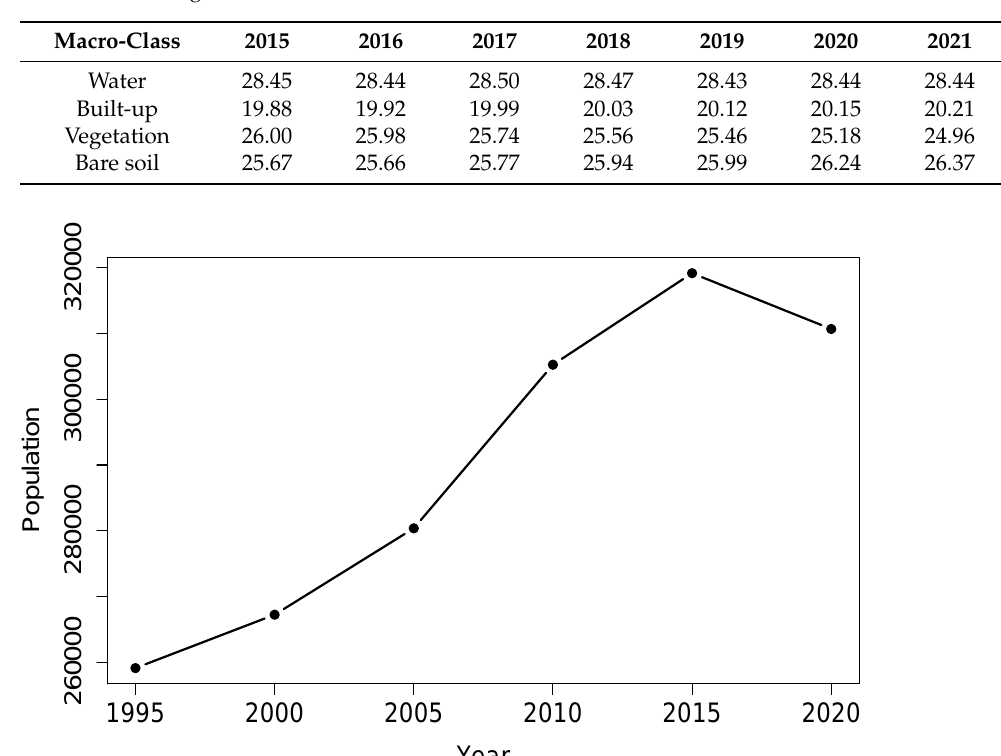
Table 7. Percentage area estimated for the macro-class-based classification.